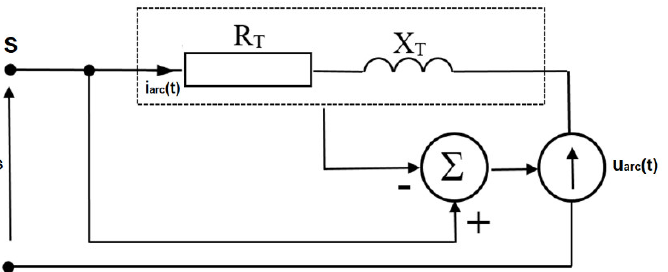
Figure 15. The arc furnace model based on the harmonics of the electric arc voltage (HVSM).